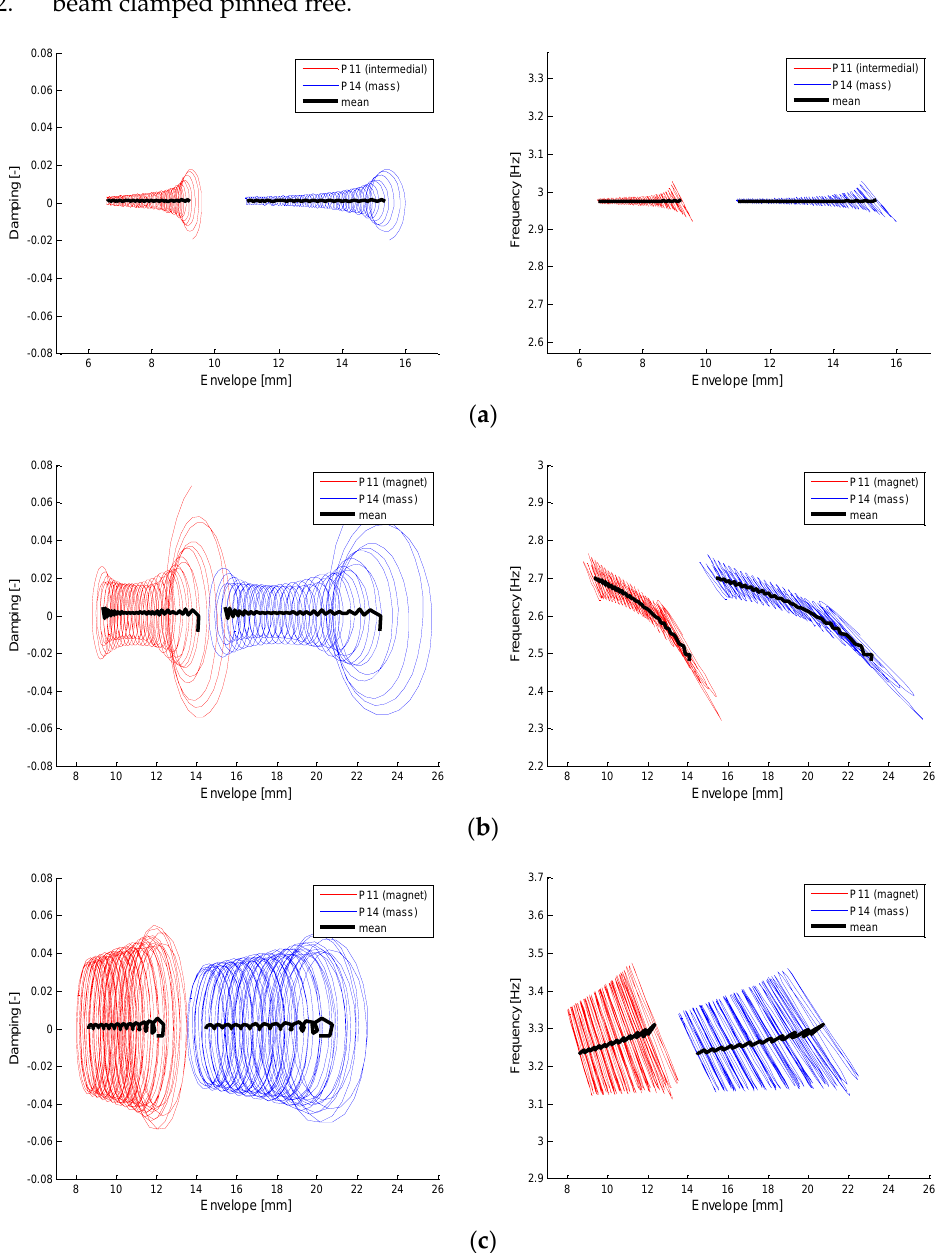
( ) A t ( )  t ( ) A t Figure 19. Envelope function A ( t ) and damping ζ ( t ) (left), and envelope function A ( t ) and instan- Figure 19. Envelope function and damping (left), and envelope function taneous frequency ω ( t ) (right), of signal z ( t ) in case of simple clamped-free beam ( a ), beam with ( )  t ( ) z t and instantaneous frequency (right), of signal in case of simple clamped-free beam attractive magnet ( b ), and beam with repulsive magnet ( c ) ( a ), beam with attractive magnet ( b ), and beam with repulsive magnet ( c ) configurations.